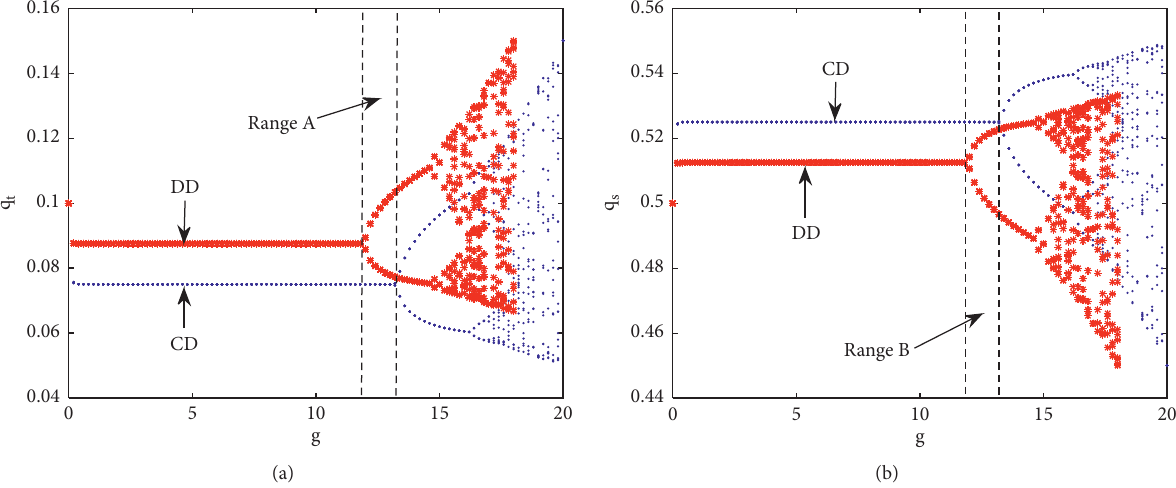
Figure 6: Bifurcation diagrams for the decisions of the capacity requestor and the capacity provider: (a) q